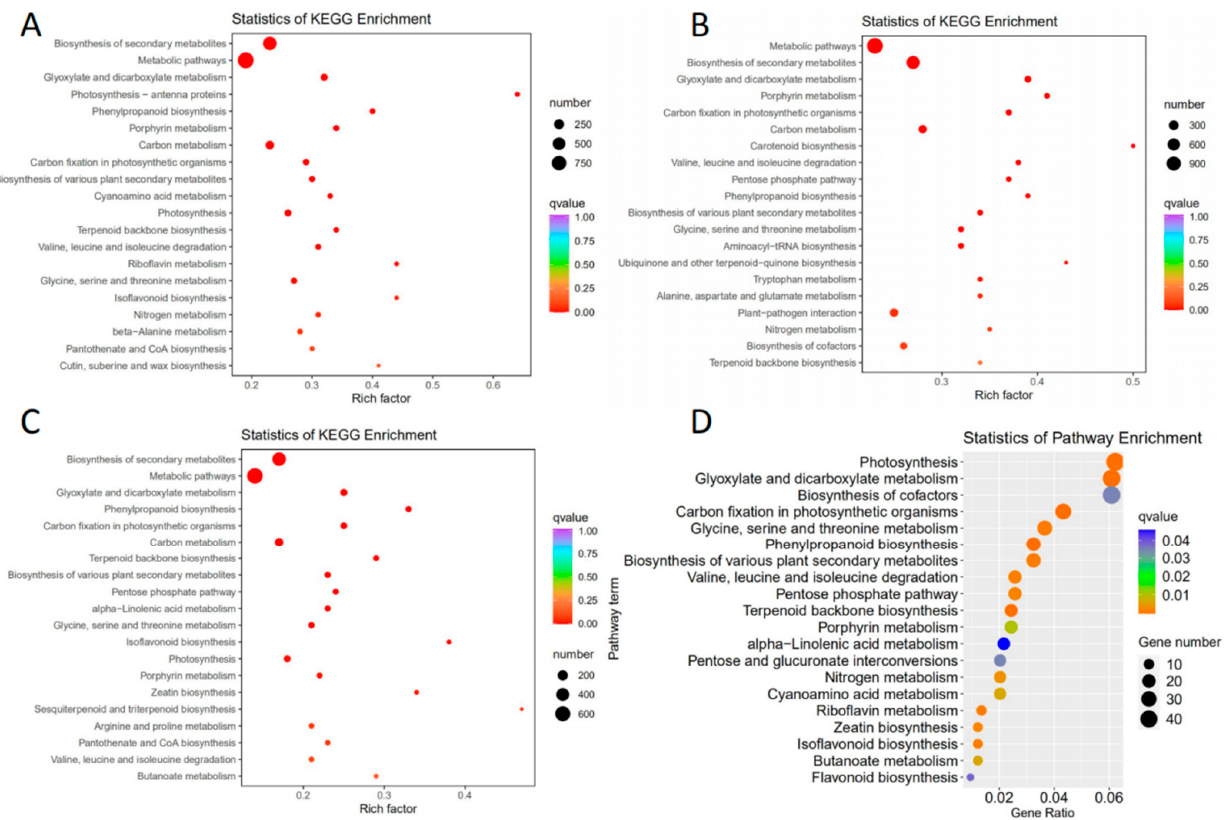
Figure 4. KEGG pathway enrichment analysis of DEGs. The 20 most enriched KEGG pathways. ( A ) CK vs. 24H. ( B ) CK vs. 48H. ( C ) CK vs. JA. ( D ) Venn.